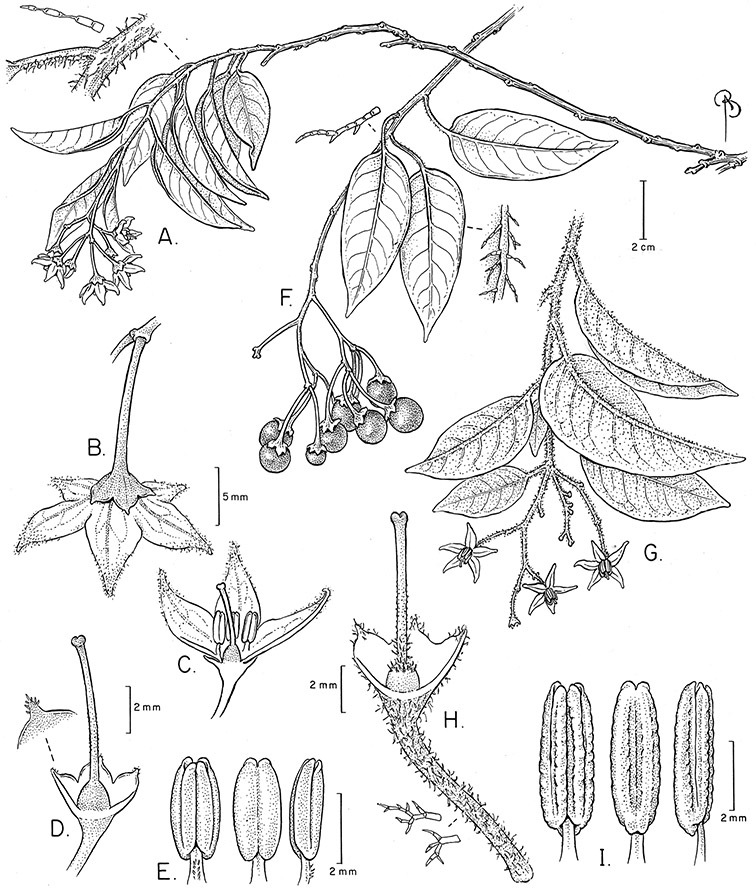
Solanum dichroandrum Dunal. (A–F drawn from Riina et al. 784
G–I drawn from Killip & Smith 17916). Illustration by Bobbi Angell.